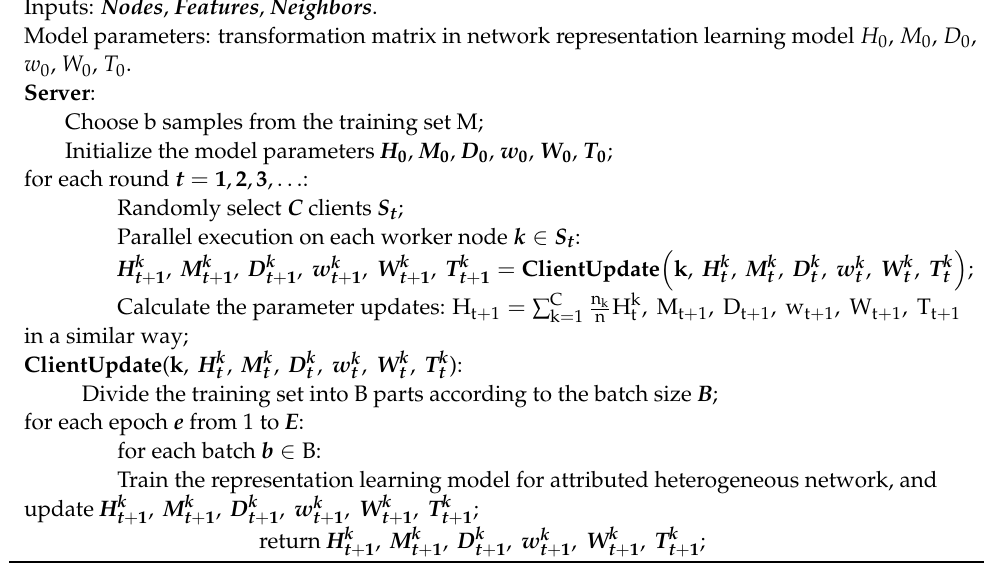
Algorithm 1. Network Representation Learning under Federated